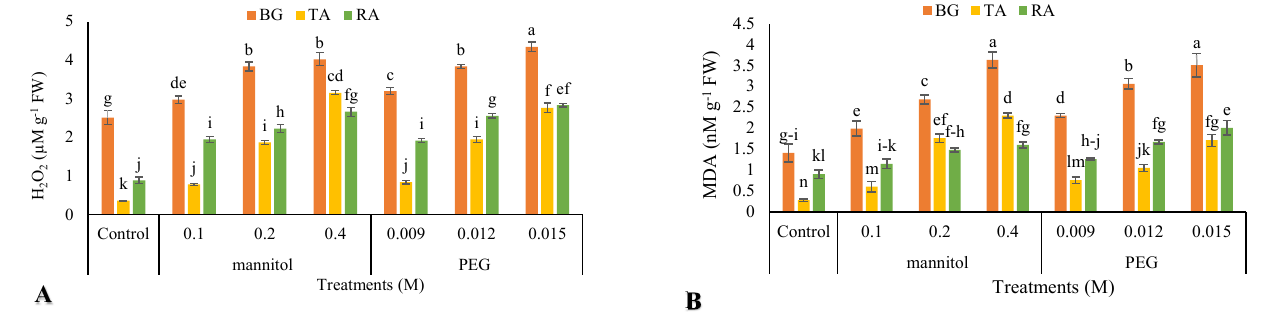
Figure 3. Effects of PEG and mannitol on H 2 O 2 ( μ M g − 1 FW) ( A ), malondialdehyde (MDA) (nM g − 1 FW) ( B ) in Cucurbita sp. genotypes under in vitro conditions. Different letters are significantly different based on Duncan’s multiple range test ( p ≤ 0.05).